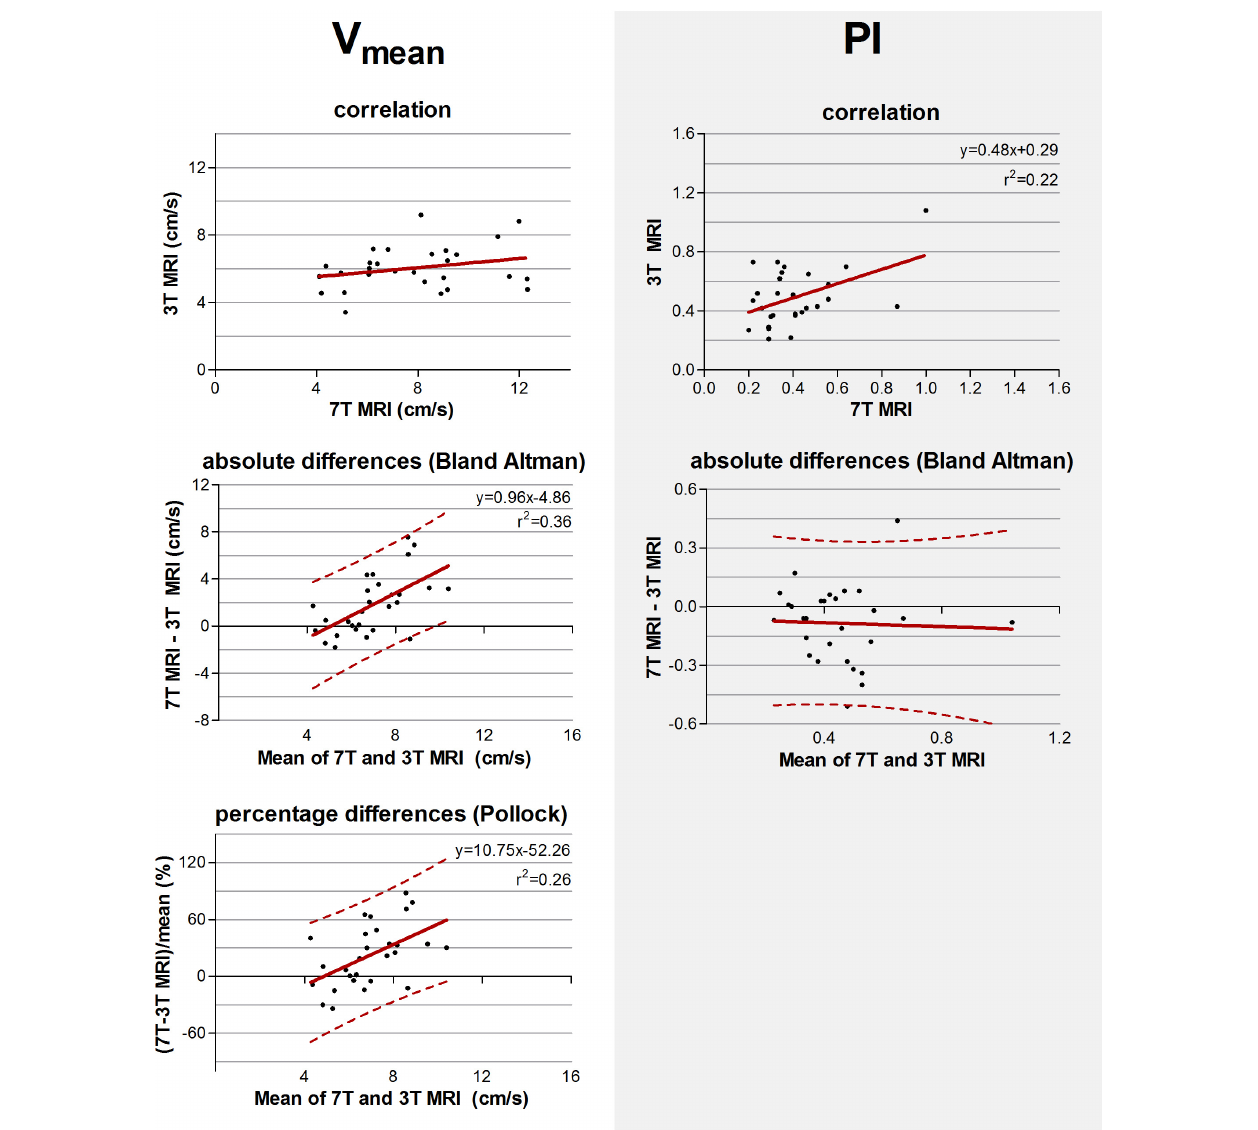
FIGURE 5 | Top row: Correlation plots of the mean blood flow velocity (V mean ) and pulsatility index (PI) determined of all detected perforating arteries at 3 tesla (T) and of the detected perforating arteries with highest velocities at 7T MRI. The line resulting from linear regression is given by the solid line. In case of a significant correlation the equation of the regression line is given. Middle and bottom row: difference plots in absolute units (Bland Altman) and in percentage units (Pollock), respectively, for V mean and PI. The regression line (i.e., bias) (solid line) and the limits of agreement (dotted lines) are shown. In case of a significant linear correlation, the equation of the regression line is presented. If proportional bias is absent in the Bland Altman plot, no Pollock plot is